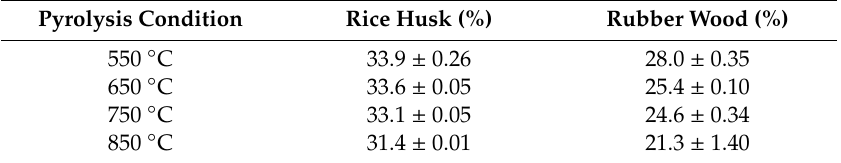
Table 1. Biochar yield from woody and non-woody biomass pyrolysed under di ff erent temperature.